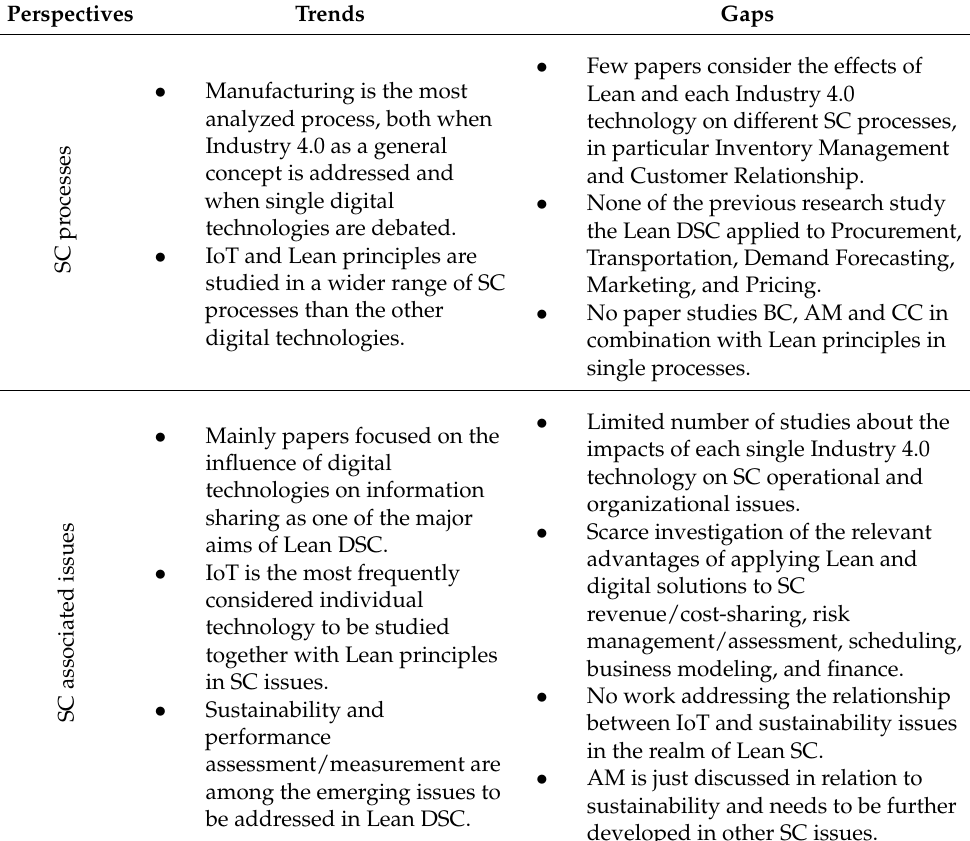
Table 3. Main identified trends and